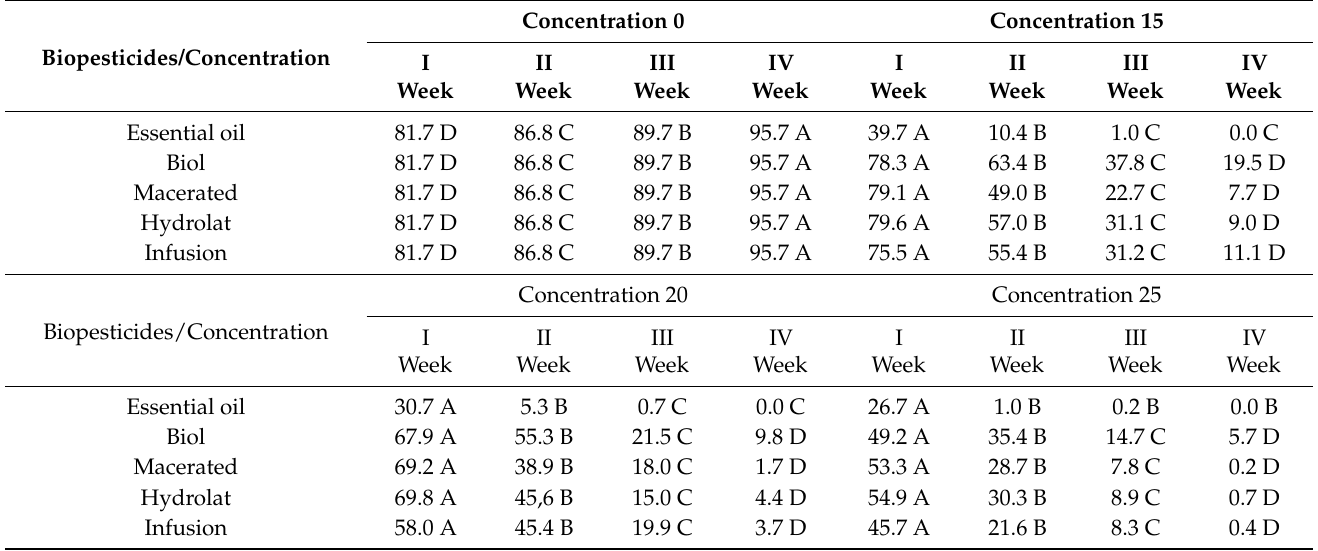
Table 3. Comparison of means in relation to the incidence of five biopesticides in the coffee crop for the control of rust, applied at four concentrations and evaluated on four different dates after field